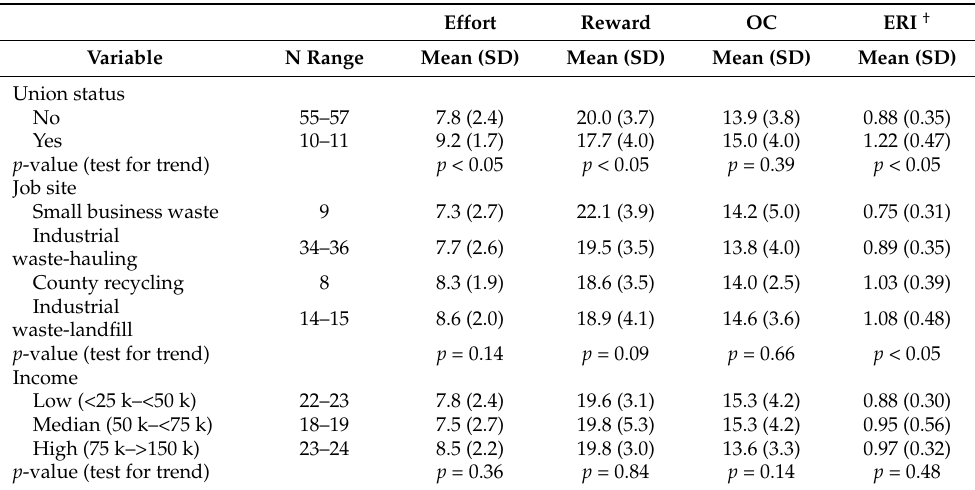
Table 3. Psychometric scales by union status, job site, and